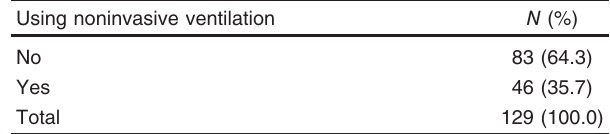
Table 19 Distribution of doctors according to using noninvasive ventilation in chronic obstructive